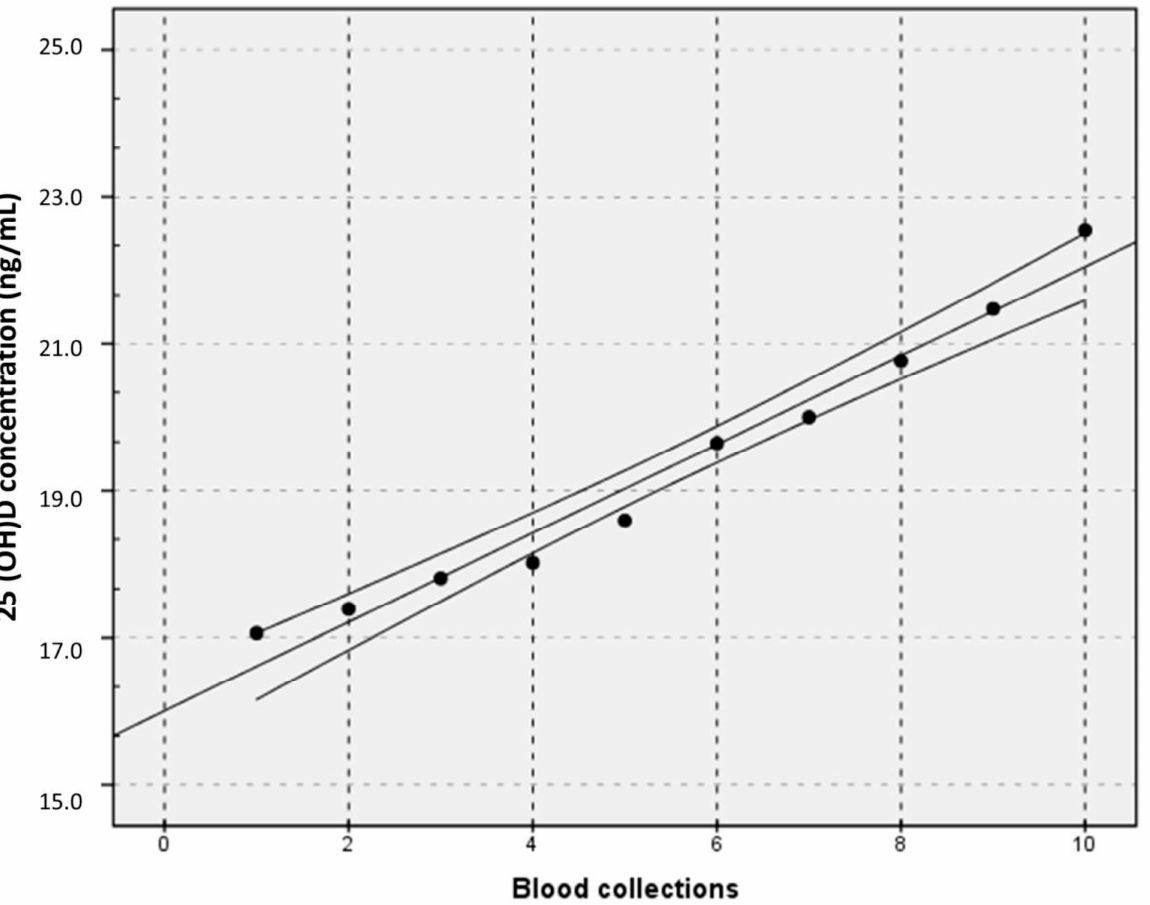
Figure 3. An x/y plot for vitamin D mean values (Y) versus blood collections (X). Linear regression equation with 95% CI: Y (ng/mL) = 0.604 × (0.52 − 0.70) + 16.0 (15.5 − 16.5); Pearson correlation coefficient ( r ) = 0.985.